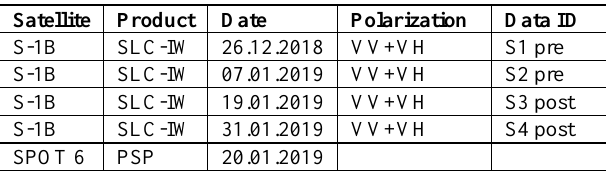
Table 1. Properties of SAR and optical